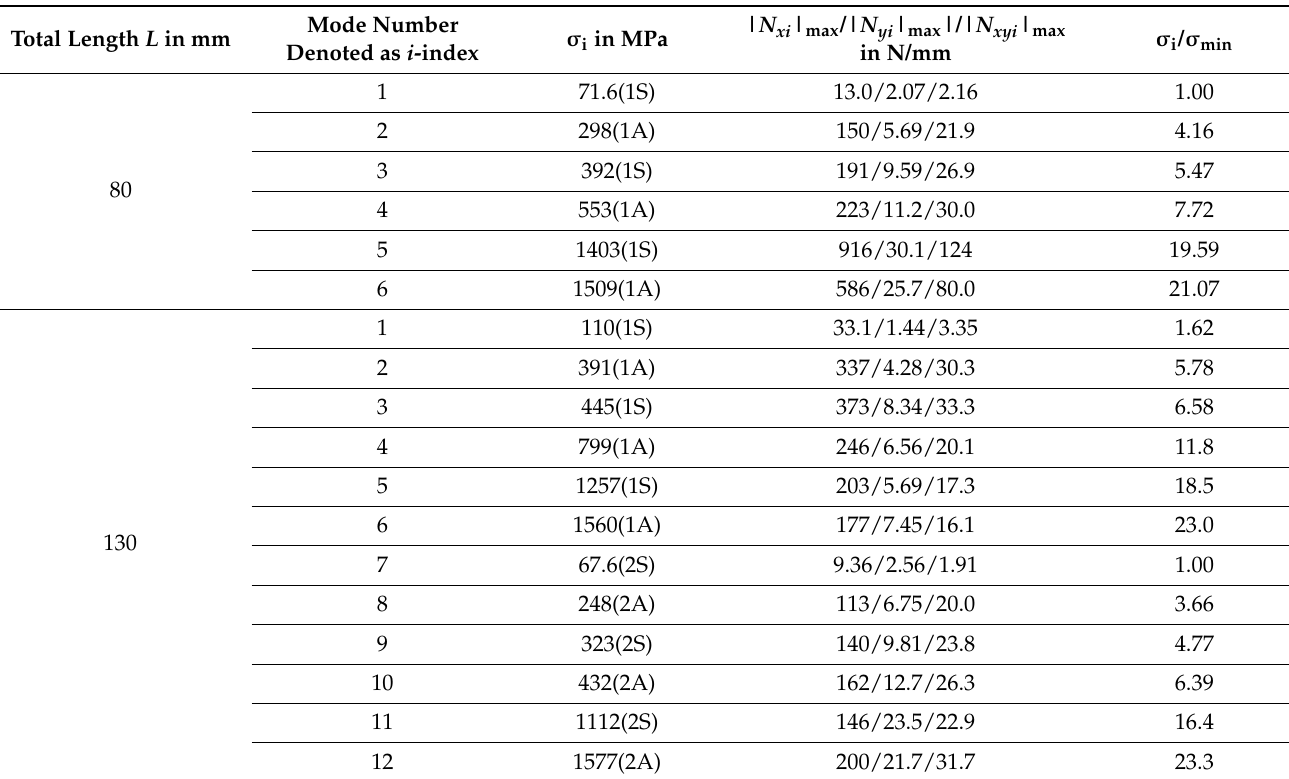
Maximal values of cross-sectional forces for anti-symmetrical modes are presented in Figure 13. Maximal longitudinal forces are (Figure 13a), correspondingly, for the curves: 1A has a maximal value of 300 N/mm and for lengths 60–250 mm are higher than 100 N/mm; the curve 2A has two maxima: 350 N/mm for the range 50–170 mm and 160 N/mm for 250–480 mm; the curve 3A has two maxima as well: 600 and 200 N/mm for the range 60–300 mm. As can be easily noticed in Figure 13b, transverse forces do not exceed the following values for the curves: 1A: 25 N/mm, 2A: 35 N/mm, 3A: 45 N/mm. Shear forces are (Figure 13c), correspondingly: 1A: 30 N/mm, 2A: 40 N/mm, 3A: 80 N/mm. Comparing the plots for TH-columns (Figures 12 and 13) to C-columns (Figures 4 and 5), maximal values of inner forces occur for shorter lengths of structures under compression, which is caused by boundary reinforcements of TH-columns in relation to C-columns. Considering maximal absolute values of longitudinal forces in evaluation of their influence on the load-carrying capacity of hybrid TH-channels, the following lengths were selected: 80, 130, 225, and 330 mm. In Table 3, values of bifurcational stresses and maximal values of membrane sectional forces for columns with two total lengths of 80 and 130 mm, corresponding to three symmetrical and anti-symmetrical buckling modes regarding the axis of symmetry, are presented. The ratios of values of subsequent bifurcational loads to the lowest value of the bifurcational load σ i / σ 4 are included. For the TH-column of the total length 80 mm (Table 4), the lowest value of bifurcational load occurs for the symmetrical mode (S) with the number of half-waves along the longitudinal direction equal to m = 1S (mode 1 in Table 3). As one can easily see, values of longitudinal inner forces are significantly higher than 100 N/mm, except for the lowest value of bifurcational load σ 1 . Table 3. Values of bifurcational stresses and the corresponding maximal absolute values of membrane sectional forces for the TH-channel of two lengths (the analytical-numerical method (ANM) results). Total Length L in